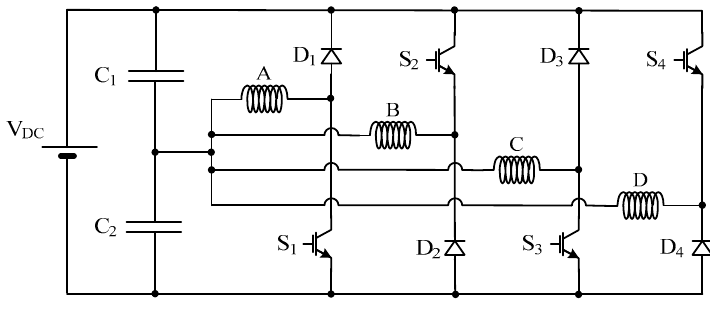
Figure 9. Split DC topology.